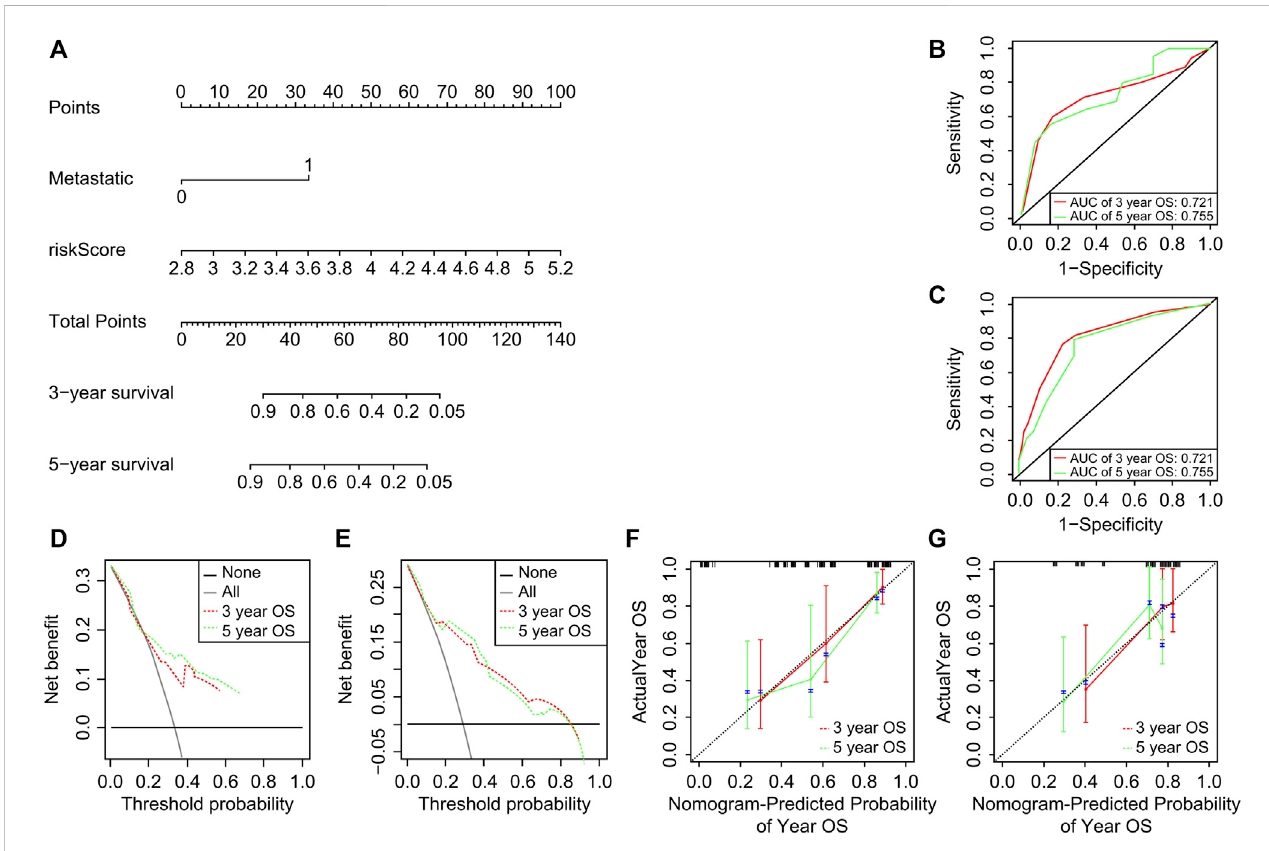
FIGURE 6 Construction and evaluation of the nomogram. (A) Nomogram constructed using the training set. (B, C) Receiver operating characteristic curves and validationusingthetestset. (D,E) Decisioncurveanalysisclinicaldecisioncurvesforthetestandvalidationsets. (F,G) Calibrationcurvesfortestandvalidation sets. OS,